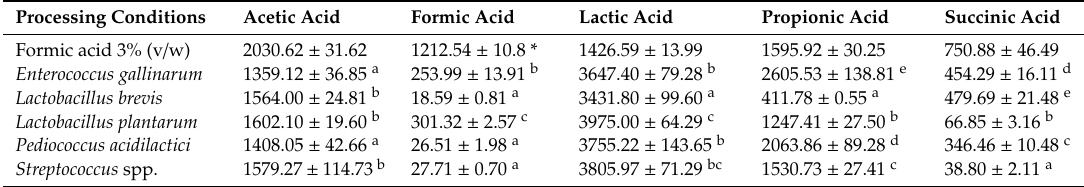
Table 8. Yields (mean value ± standard deviation, expressed in mg organic acid / 100 g sample ) ( n = 3) of organic acids in acidified and fermented spray-dried klunzinger’s ponyfish ( Equulites klunzingeri ) silages of 3 weeks. In the fish silages, the acidic conditions were obtained by adding formic acid 3% (v / w), whereas the fermentation were carried out by independent inoculations with pure cultures of distinct lactic acid bacteria (LAB).